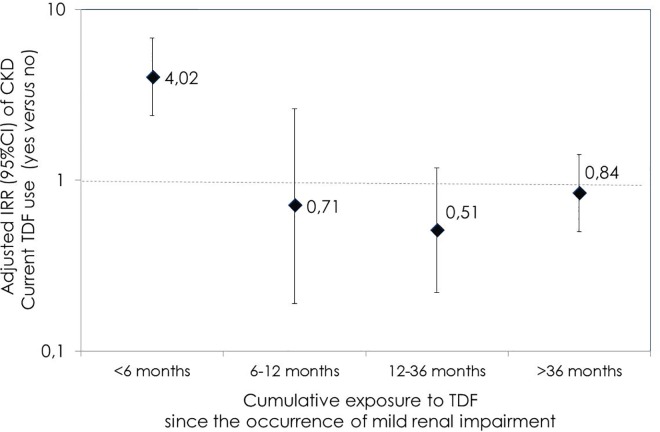
Association between current TDF use and CKD, based on cumulative exposure to TDF after mild renal impairment occurrence.eGFR was calculated using Chronic Kidney Disease Epidemiology Collaboration (CKD-EPI) formula.[8] Chronic Kidney Disease was defined as two eGFR <60 ml/min measured 3–6 months apart. Abbreviations: CI, confidence interval; CKD, chronic kidney disease; TDF, tenofovir disoproxil fumarate.